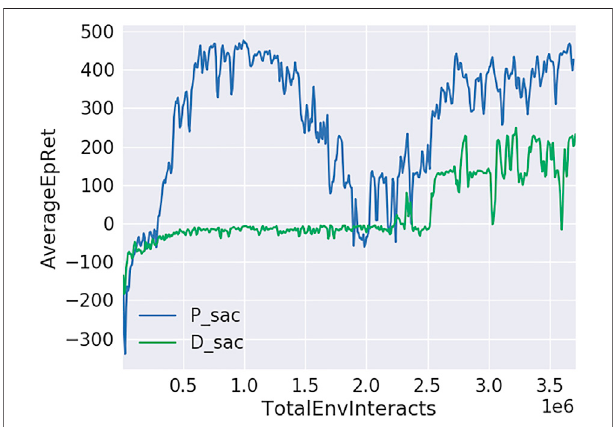
FIGURE 7 | Average epoch reward curves of D-SAC and